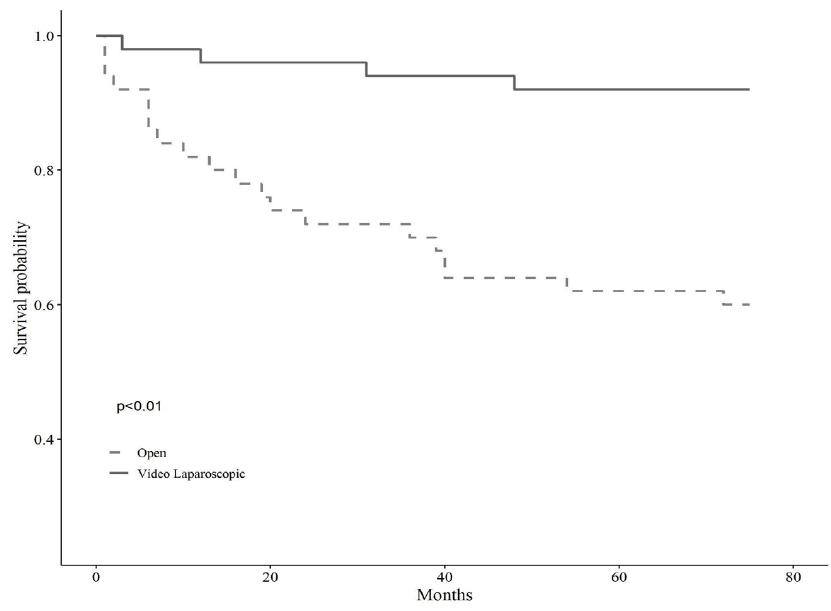
Figure 2. Kaplan Meir curves on relapse of tumor according to the type of surgery. Figure 1. Kaplan Meir mortality curves according to the type of surgery. A propensity score matching balance table is included in Table 2. Table 2. Propensity score matching balance table.